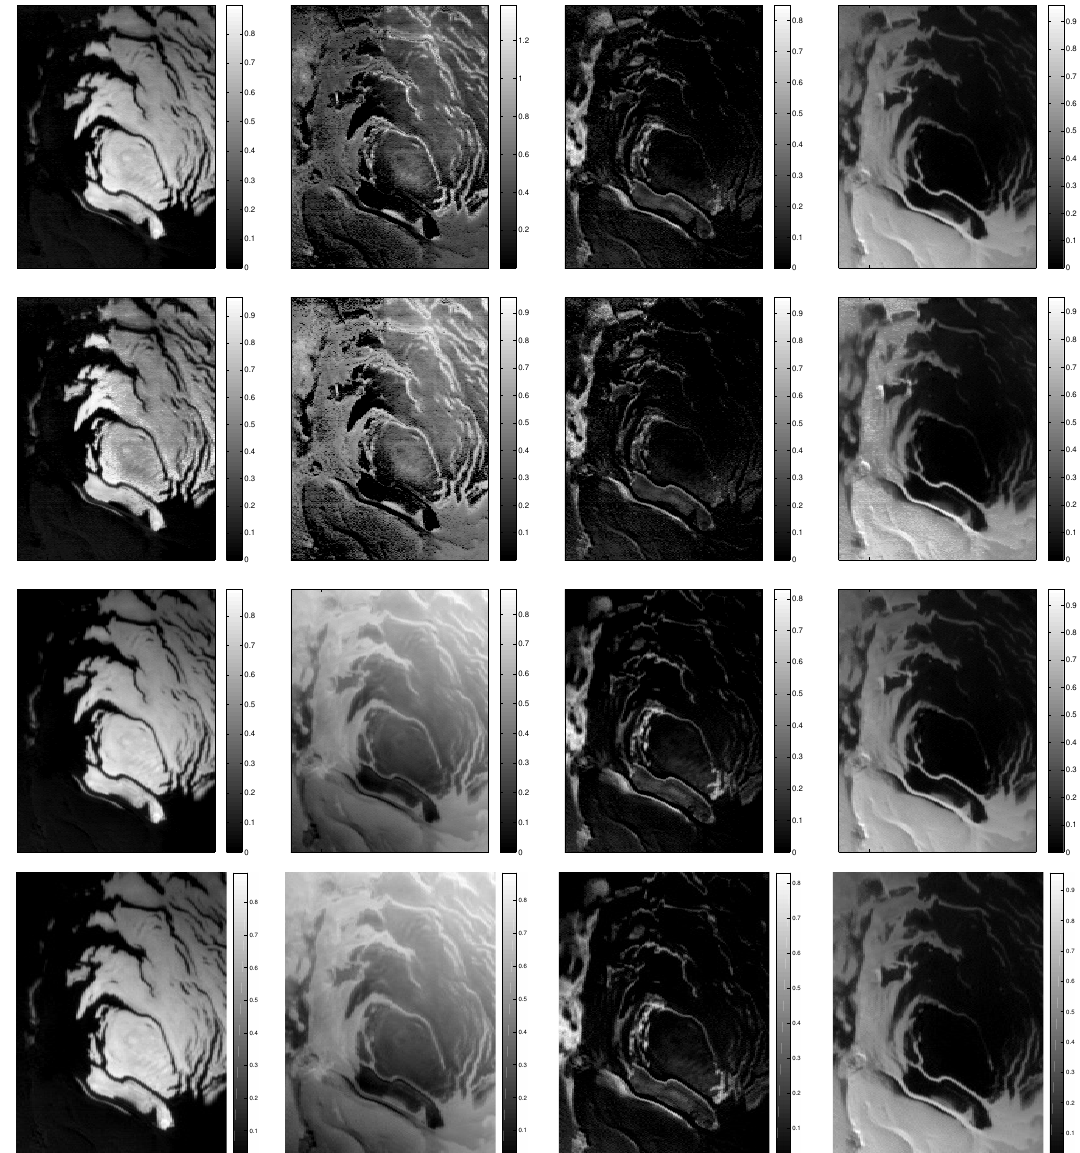
Figure 11. Abundance maps computed with the spectra of the endmembers extracted by MVC-NMF. The abundances are, respectively, estimated by the use of NNLS (first row), normalized NNLS abundances by the use of Equation (13) (second row), FCLS (third row) and MLMp (fourth